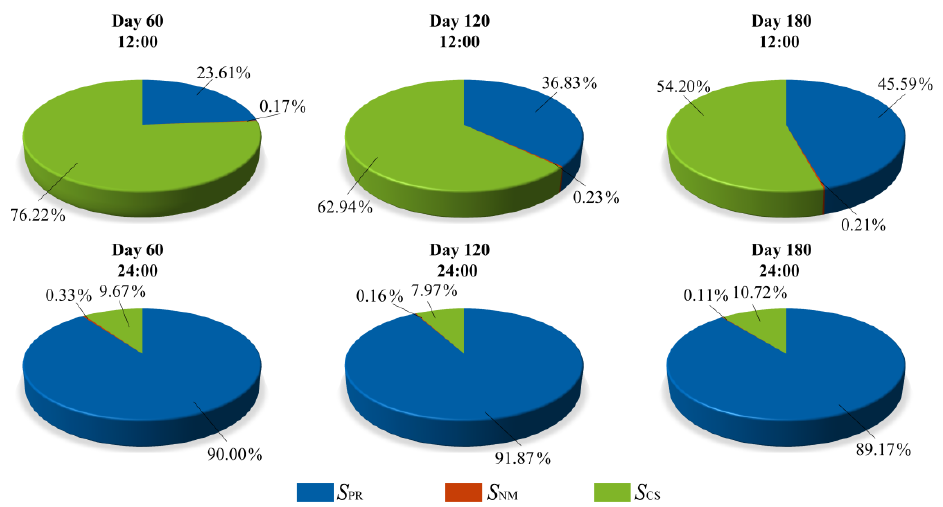
Figure 6. Estimated sensitivities for the spatially averaged evapotranspiration (ET) at six time points (simulation times are 1428h (Day 60, 12:00), 1440h (Day 60, 24:00), 2868h (Day 120, 12:00), 2880h (Day 120, 24:00), 4308h (Day 180, 12:00), and 4320h (Day 180, 24:00)). S PR is the sensitivity index for the parameters. S NM is the sensitivity index for the numerical models, and S CS is the sensitivity index for the climate scenarios.